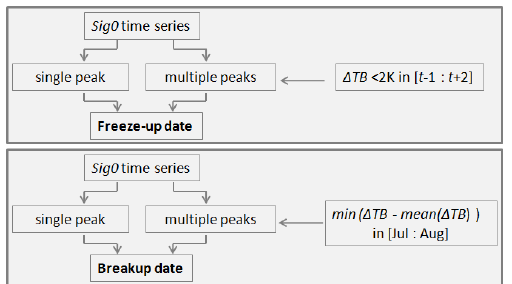
Figure 4. Processing scheme of retrieving ice phenology dates from altimetric